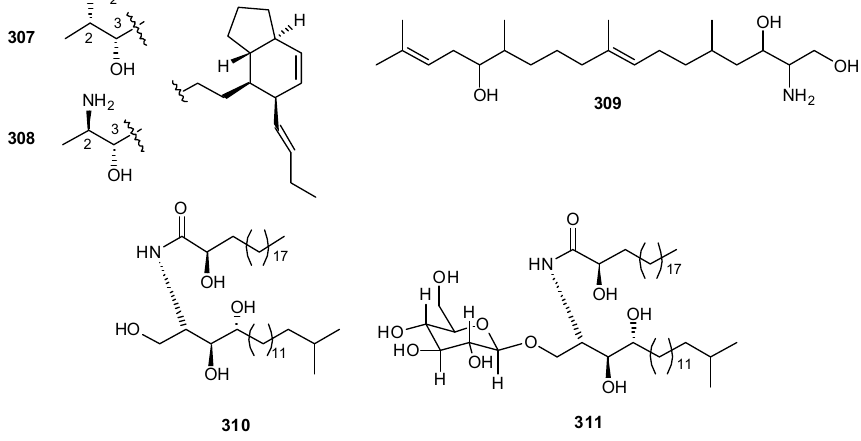
Figure 31. Structures of amaminols ( 307 , 308 ), aplidiasphingosine ( 309 ), and lipids 310 and 311 .